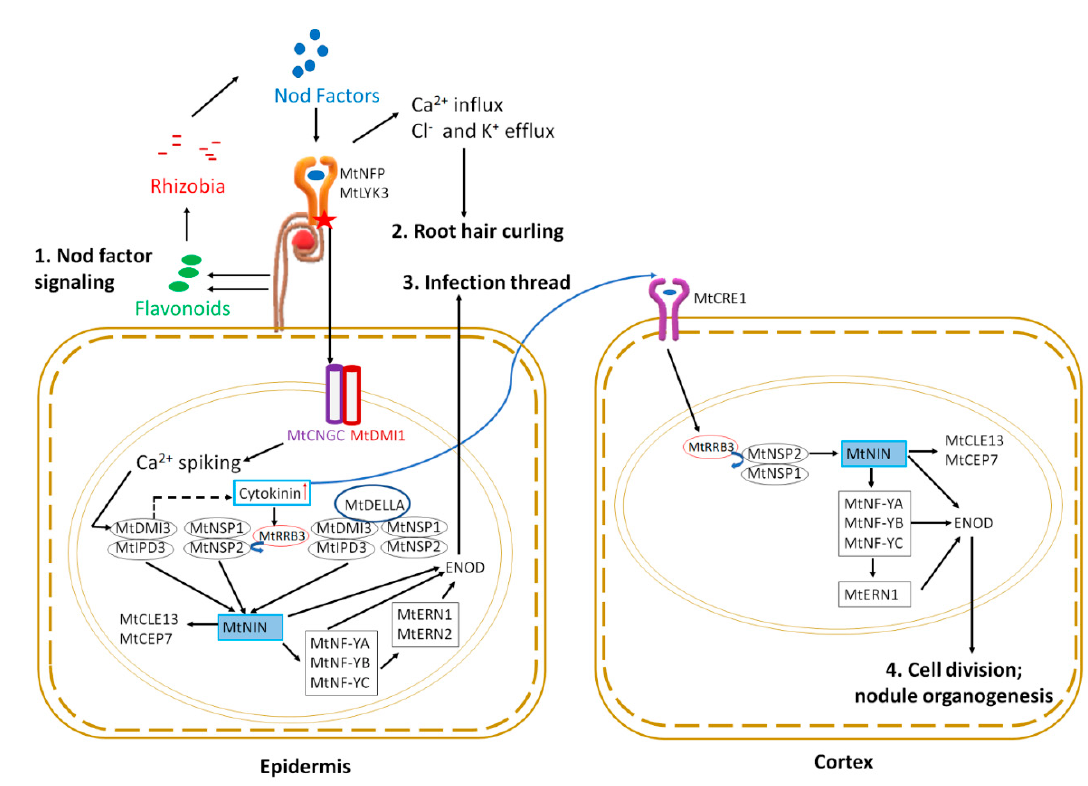
Figure 1. Early symbiotic signaling in epidermis and cortex during nodulation. Nod factor signaling: (1) the process starts with Nod factor signaling initiated by plants by producing flavonoids that attract rhizobia. Rhizobia produce Nod factors that bind to root hair receptors (MtNFP and MtLYK3), initiating the intracellular signaling cascade in the nucleus described in the text. Nuclear signaling leads to altered ion fluxes resulting in root hair curling (2). Simultaneously, Ca2+ spiking activates MtNIN through activation of a series of transcription factors; expression of early nodulin (ENOD) genes, such as ENOD11 and ENOD12 , facilitates infection thread progression (3). MtNIN also induces the expression of two small peptides, MtCEP7 and MtCLE13. Cytokinin signaling through MtCRE1 mediates MtNIN, MtNF-Y, and MtERN production in the cortex, which upregulates ENOD expression leading to cortical cell division; (4) and nodule organogenesis (see text for details).